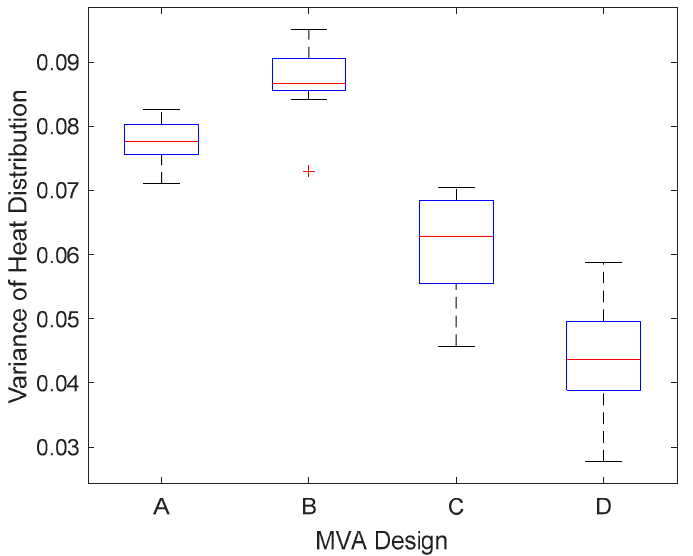
Figure 9. Box and whisker plot of the heat spreading characteristics for each design of MVA.